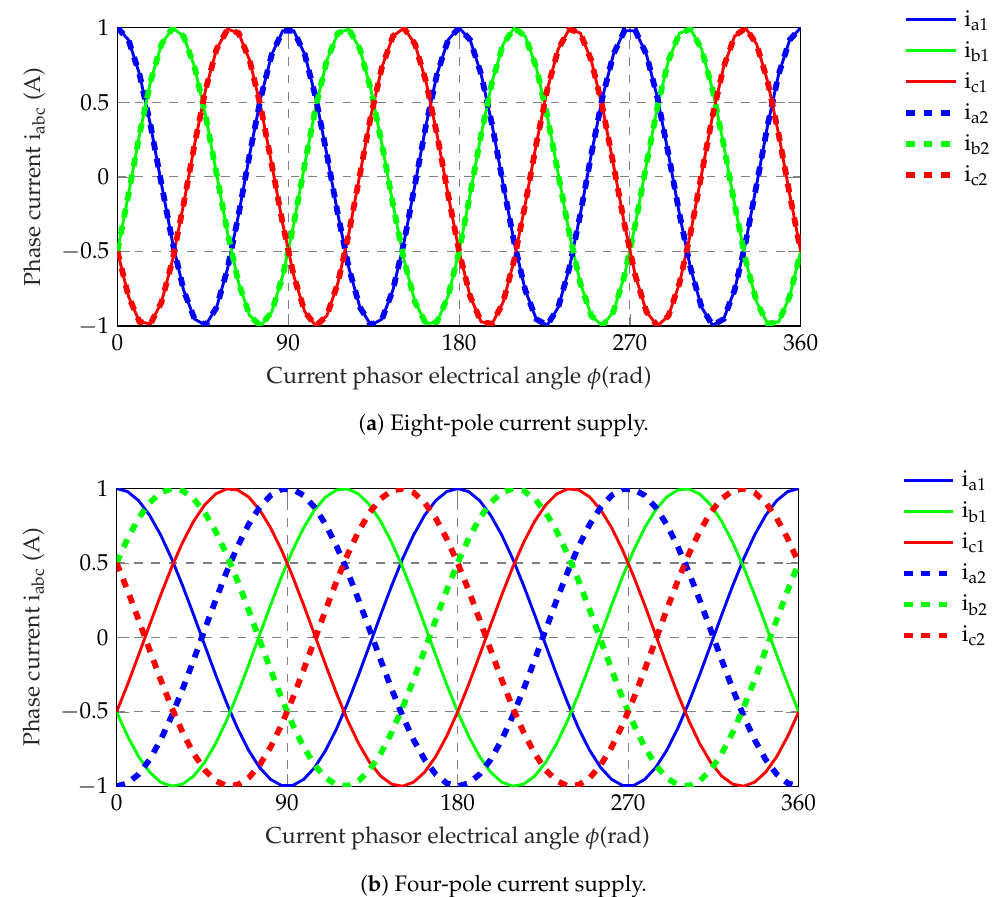
Figure 6. Current supplied by the two inverters with 8-pole and 4-pole configurations.